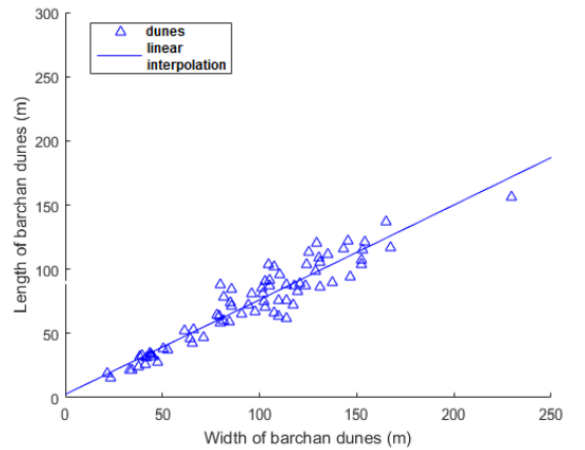
Figure 8: Dunes length as function of dunes